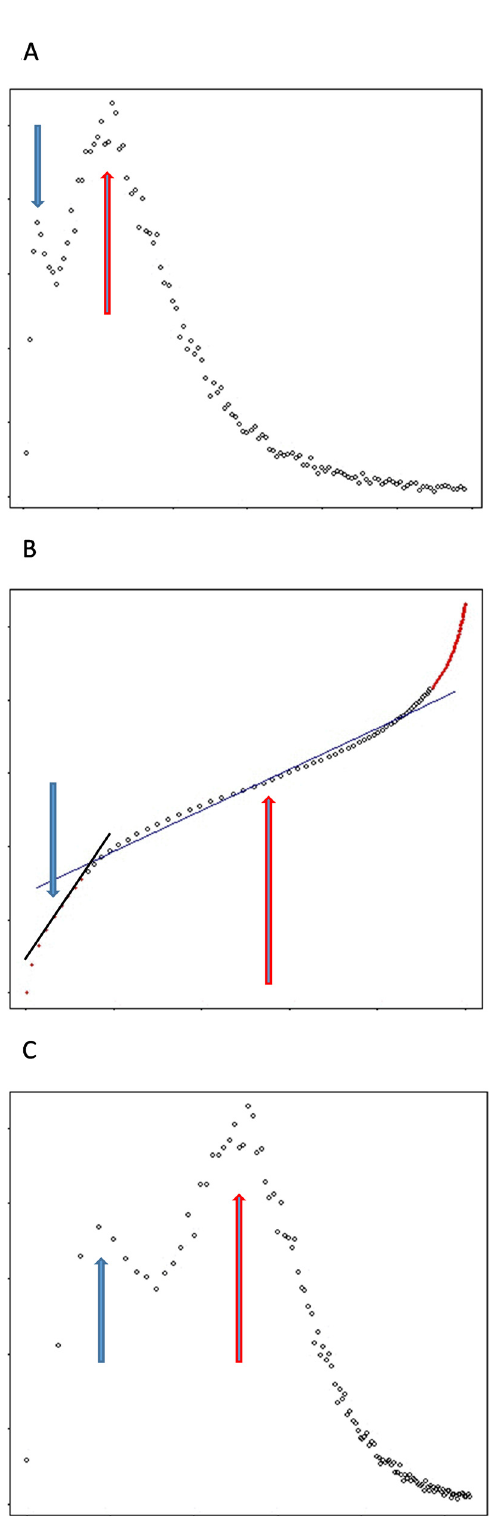
Figure 1: Distribution graphs.